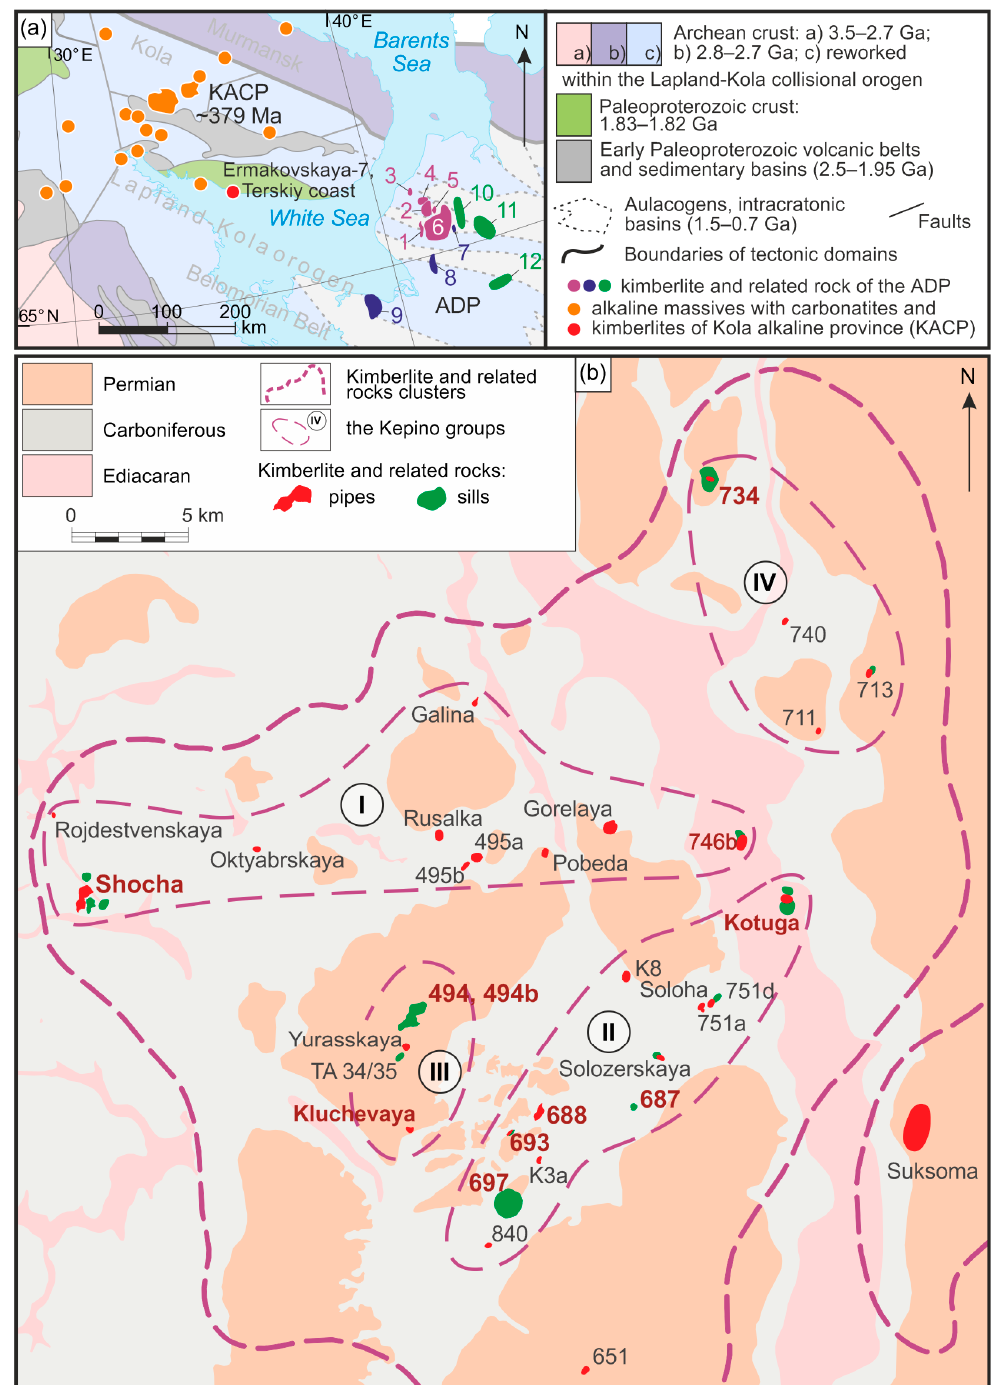
Figure 1. ( a ) Precambrian crust of the Fennoscandia (northeastern Archean part) after [47], showing areal extents of alkaline–ultramafic magmatism within the Kola alkaline carbonatite province (KACP) and the Arkhangelsk diamond province (ADP). The kimberlite and kimberlite-related rocks of the ADP: 1–6 are Zolotica (1), Chernoozero (the Grib pipe) (2), Mela River sills (3), Megorsk (4), Verhotina (5), and Kepino (6) clusters; 7–9 are picrites and olivine melilitites of the Suksoma (7), Chidviya-Izhma (8), and Nenoksa (9) clusters; 10–12 are basalts of the Soyana (10), Koval-Poltozero (11), and Chuplega-Pinejozero clusters (12). The ages of magmatism after [34,43]. ( b ) The schematic geological map of the Kepino kimberlite and kimberlite-related rocks cluster with the position of pipes and sills under overlying Permian and Carboniferous sedimentary rocks. The Kepino groups: I—Shocha-group; II—Pachuga- group; III—Kluchevaya-group; IV—Soyana-group.